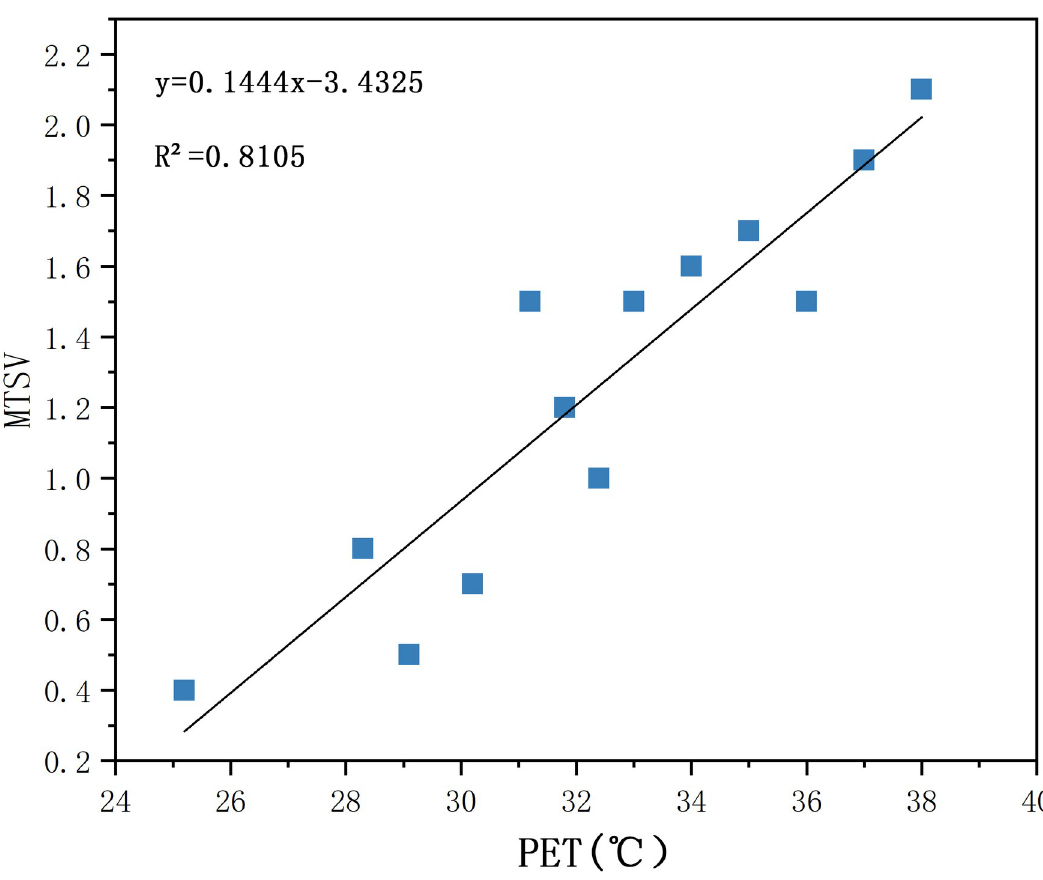
Fig 10. Correlation between PET and